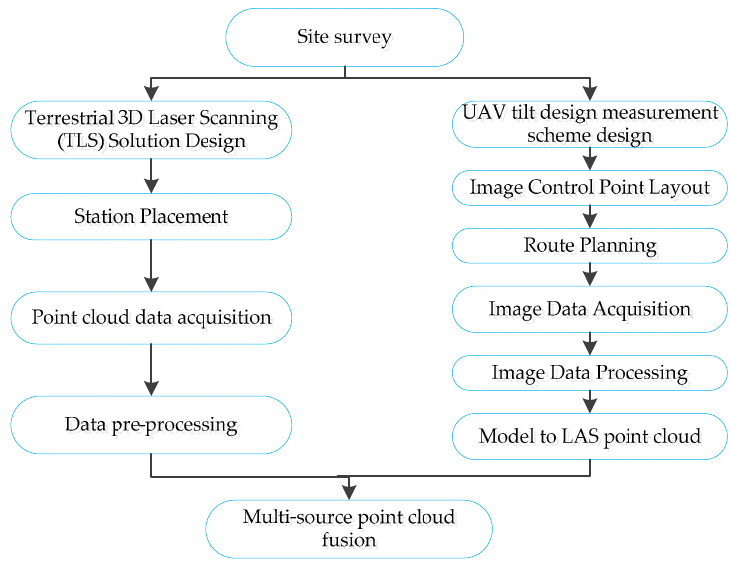
Figure 3. Flow chart of point cloud data acquisition.